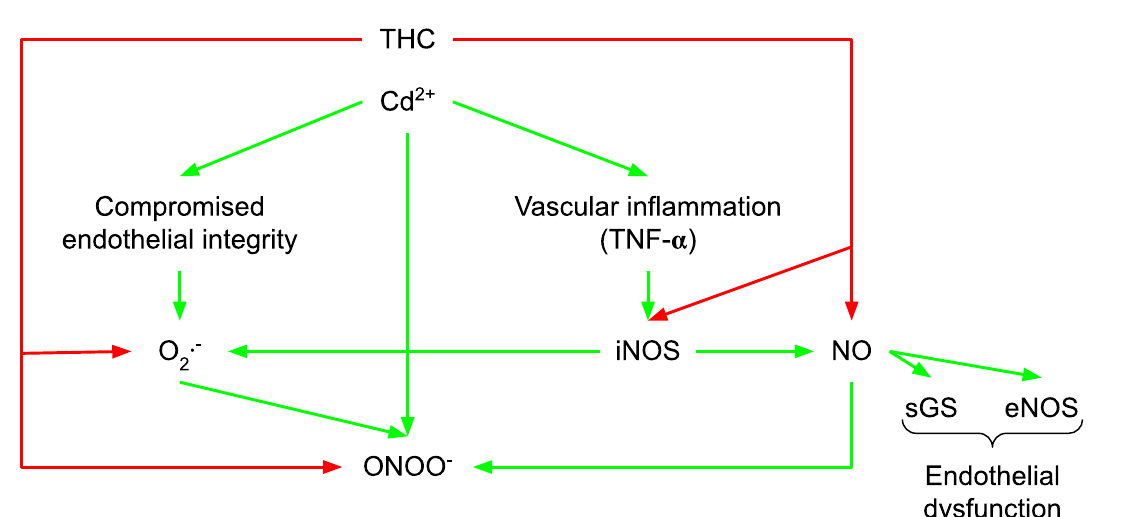
Figure 2. Protective effects of THC in Cd 2+ -induced hypertension. THC administration lowers Cd 2+ -induced aortic O 2 − generation and the urine nitrate/nitrite ratio in a dose-dependent manner. Reduced iNOS expression is linked to lower O 2 − levels and a lower nitrate/nitrite ratio, which inhibits ONOO − production and increases NO bioavailability. THC, tetrahydrocurcumin; Cd 2+ , cadmium; O 2 − , superoxide radical; iNOS, inducible nitric oxide synthase; ONOO − , peroxynitrite; NO, nitric oxide; red arrow, inhibitory effect; green arrow, stimulatory effect.